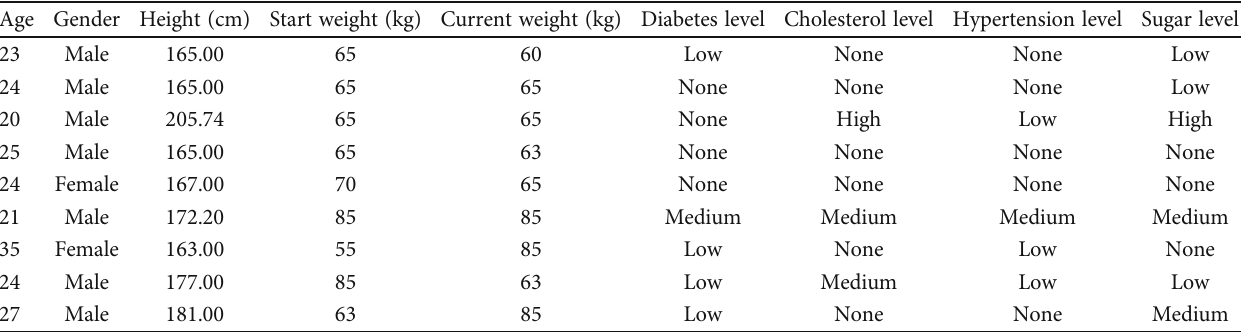
Figure 7 : Architectural diagram for obesity management software application. Table 7: Sample user data collected during the testing